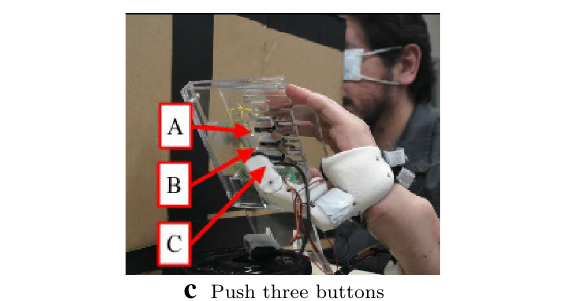
subject. The green, red and blue lines represent the aver- age successful reaching counts of ten trials in each exper- imental set when reaching targets are (1) fingertips, (2) three positions on face, and (3) auditory feedback device, respectively. The learning curves show the learning pro- cess of the ERT control for all six subjects under three